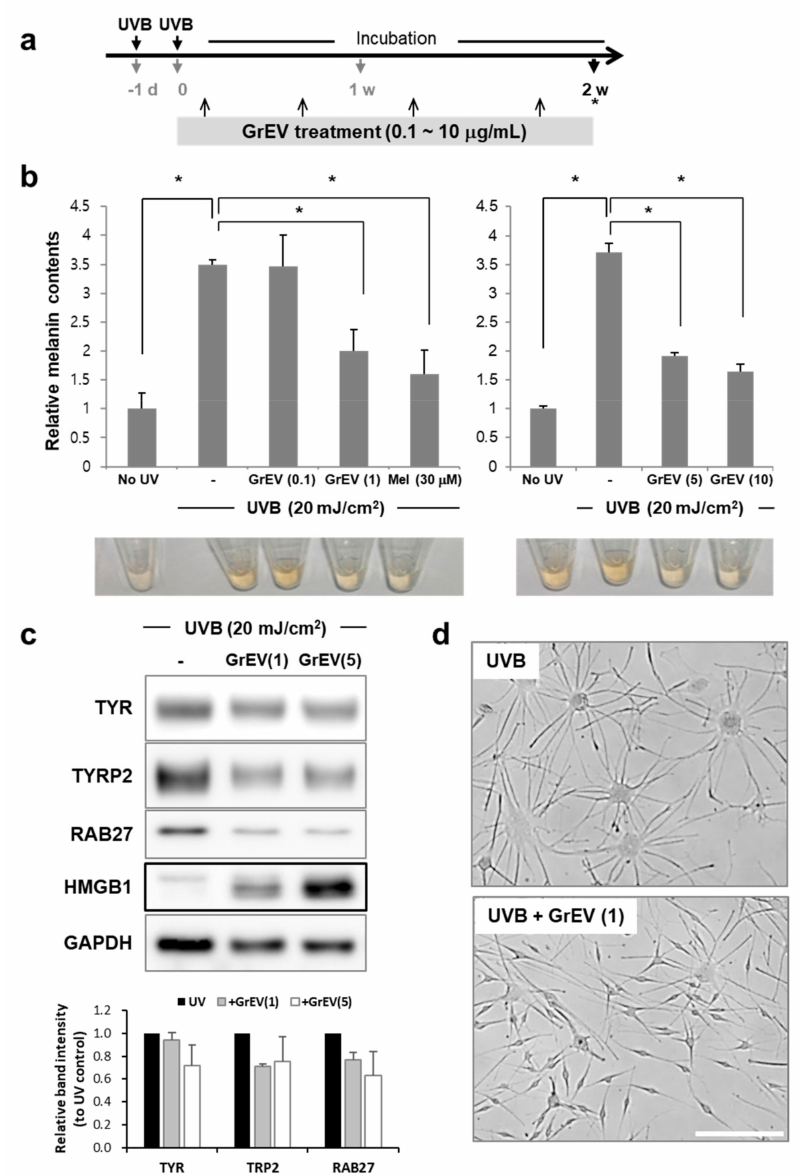
Figure 3. Ginseng root-derived extracellular vesicles (GrEVs) reveal anti-senescence and anti- pigmentation effects on human melanocytes with ultraviolet B (UVB) irradiation-induced senescence. ( a ) Scheme used to treat UVB-induced senescent human epidermal melanocytes (HEMs) with GrEVs. HEMs were exposed twice to UVB (20 mJ/cm 2 ) over a 24 h interval and treated with GrEVs at different doses (0.1, 1, 5, or 10 µ g/mL) or melasolv (30 µ M) two times during a 2 week cultivation period. ( b ) Melanin contents were determined by measuring the absorbance at 450 nm after dis- solving cell pellets in 1 N NaOH and normalizing to protein quantities. A representative image showing the color of the supernatant after dissolving in 1 N NaOH is shown in the bottom panel. The data are shown as the means ± standard deviations of three independent experiments (* p < 0.05). ( c ) Immunoblot analyses were performed on senescent HEMs treated with GrEVs (1 or 5 µ g/mL) using the indicated antibodies. Twenty-five micrograms of protein were loaded, and glyceraldehyde 3-phosphate dehydrogenase (GAPDH) expression was detected as a loading control. Densitometry analysis of each band intensity was performed using ImageJ software (https://imagej.nih.gov/ij/). ( d ) Representative phase–contrast images of HEMs at 2 weeks post-treatment with GrEVs (0 or 1 µ g/mL). Scale bar, 10 µ m. (-) in b and c, HBS